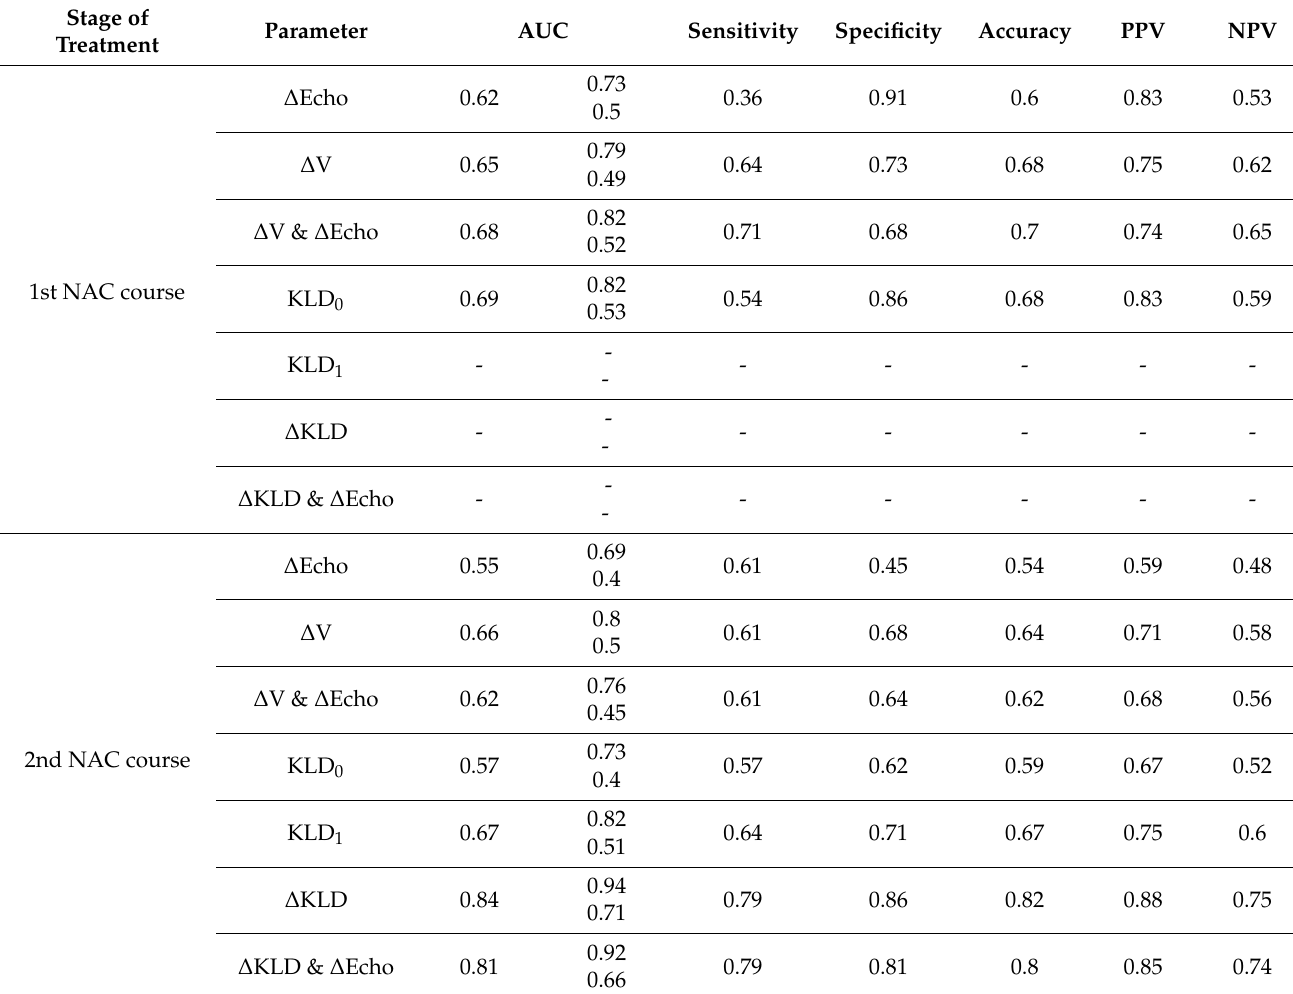
Table A2. Statistical analysis for all measured US parameters (single ∆ Echo, ∆ V, KLD 0 , and KLD 1 , and their combinations ∆ Echo with ∆ V and ∆ Echo with ∆ KLD and in combination) assessed after first, second, third, fourth courses od NAC for RMC ≤ 30%.